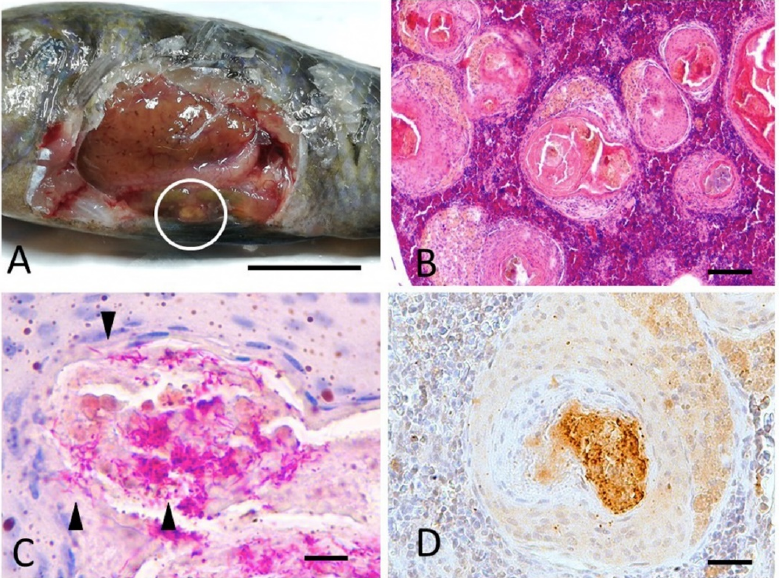
Figure 2. Case 9. Cichlid fish. M. pulpican . ( A ) Viscera. White-yellowish multifocal granulomas in the perivisceral adipose tissue and visceral organs (white circle), bar 1 cm. ( B ) Spleen. Multifocal, coalescent granulomas developing from melano-macrophagic centers (MMC) dispersed within the splenic parenchyma. Hematoxylin–Eosin staining, bar 300 µ m. ( C ) Spleen, acid-fast bacilli (arrowheads) are present within granulomas. Ziehl–Neelsen stain, bar 30 µ m. ( D ) Spleen, granular labelling to anti-Mycobacterium antibody within granuloma. Immunohistochemistry, DAB staining, bar 100 µ m.